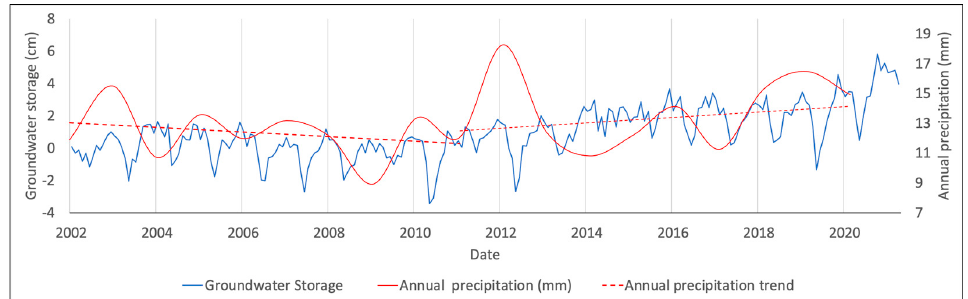
Figure 15. Groundwater storage (cm) and observed average annual precipitation (mm) of the Chad Basin.